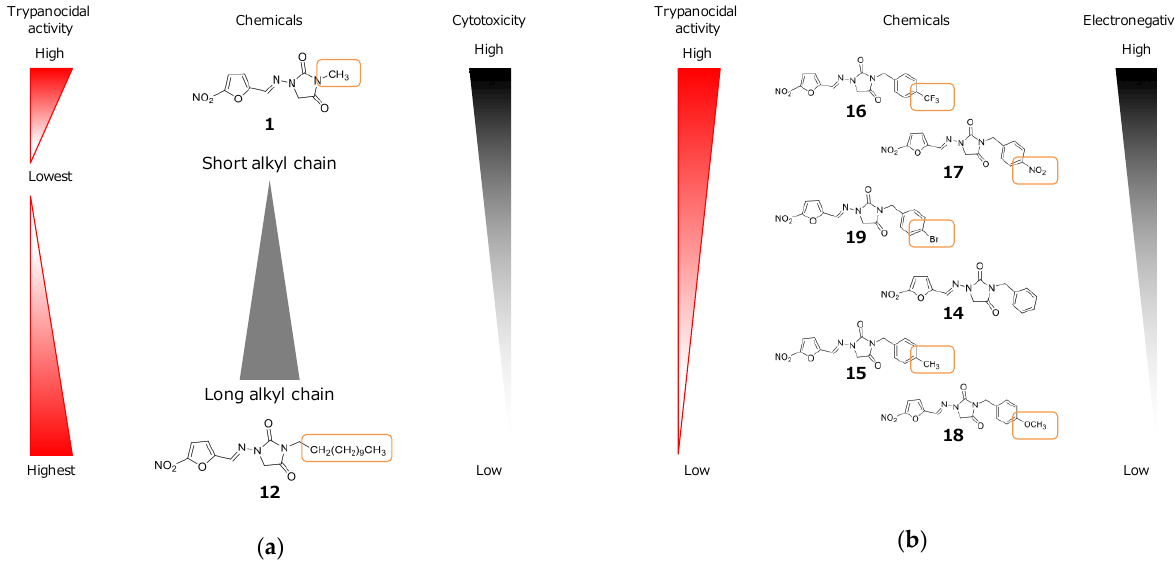
Figure 2. Summary of structure–activity relationship. The summary of structure–activity relationship between trypanocidal activity and alkyl chain length ( a ) or electronegativity ( b